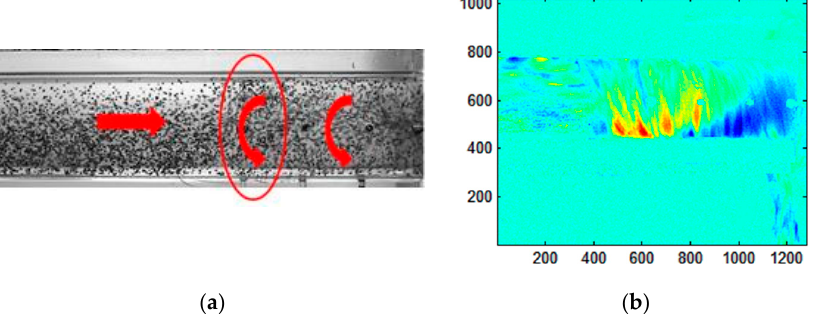
Figure 18. High speed photography result of inlet section. ( a ) The result of the inlet section, ( b ) The result of first-order spatial modal.